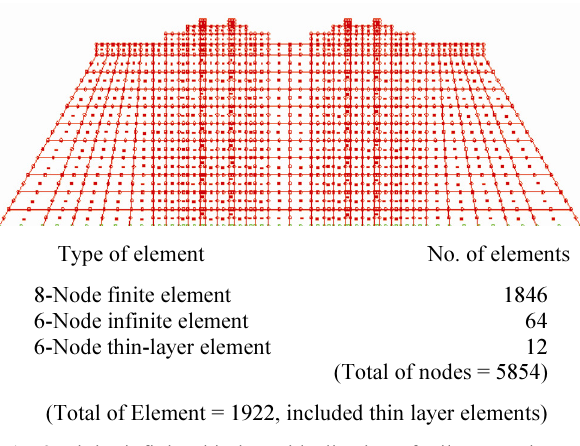
Fig. 5. Location of five nodes selected